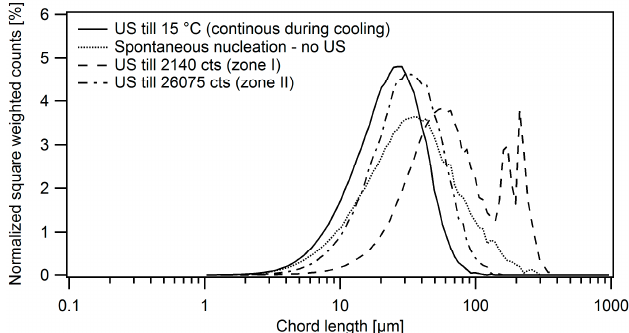
Figure 14 . Normalized square-weighted chord length distribution of final samples obtained after various sonication periods and corresponding FBRM counts at a seeding temperature of 62 °C.